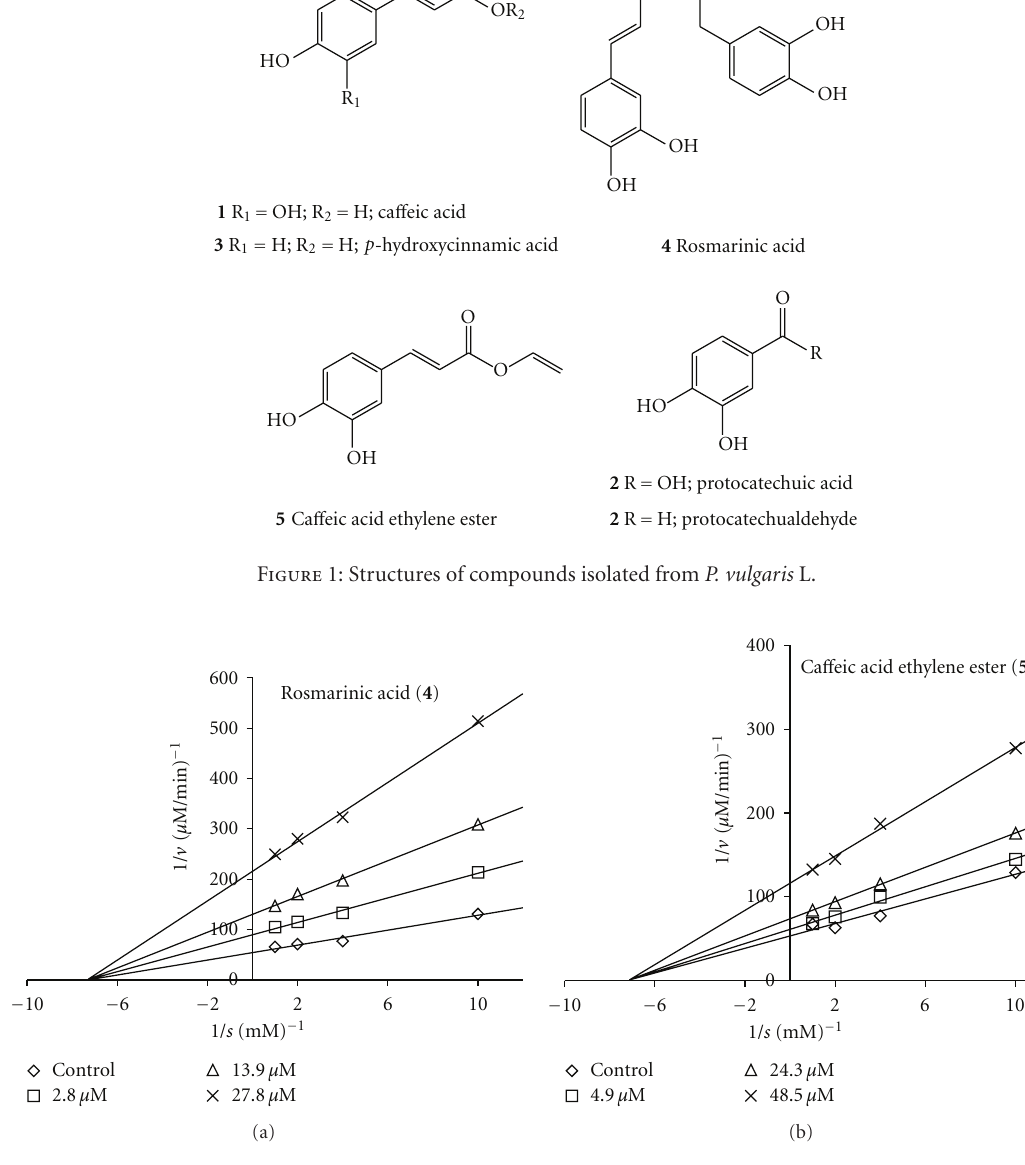
Figure 2: Lineweaver-Burk plots showing the reciprocal of the velocity (1/ v ) of recombinant human aldose reductase versus the reciprocal of the substrate concentration (1/ s ) with dl -glyceraldehyde as the substrate concentration of 0.1 to 1mM; rosmarinic acid (4), ca ff eic acid ethylene ester ( 5